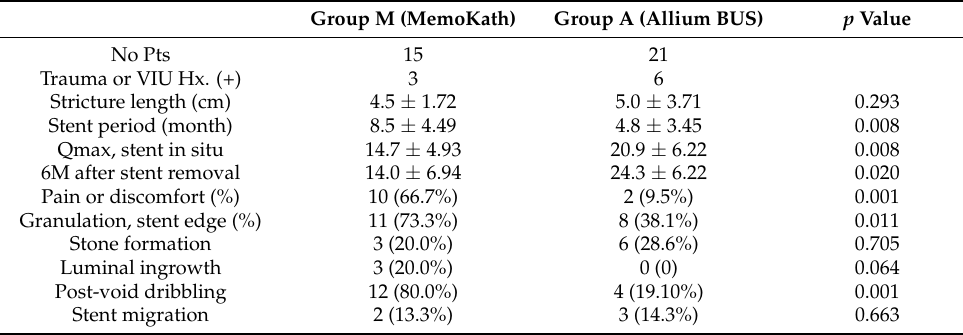
Table 1. Baseline characteristics and outcomes of stent indwelling in both